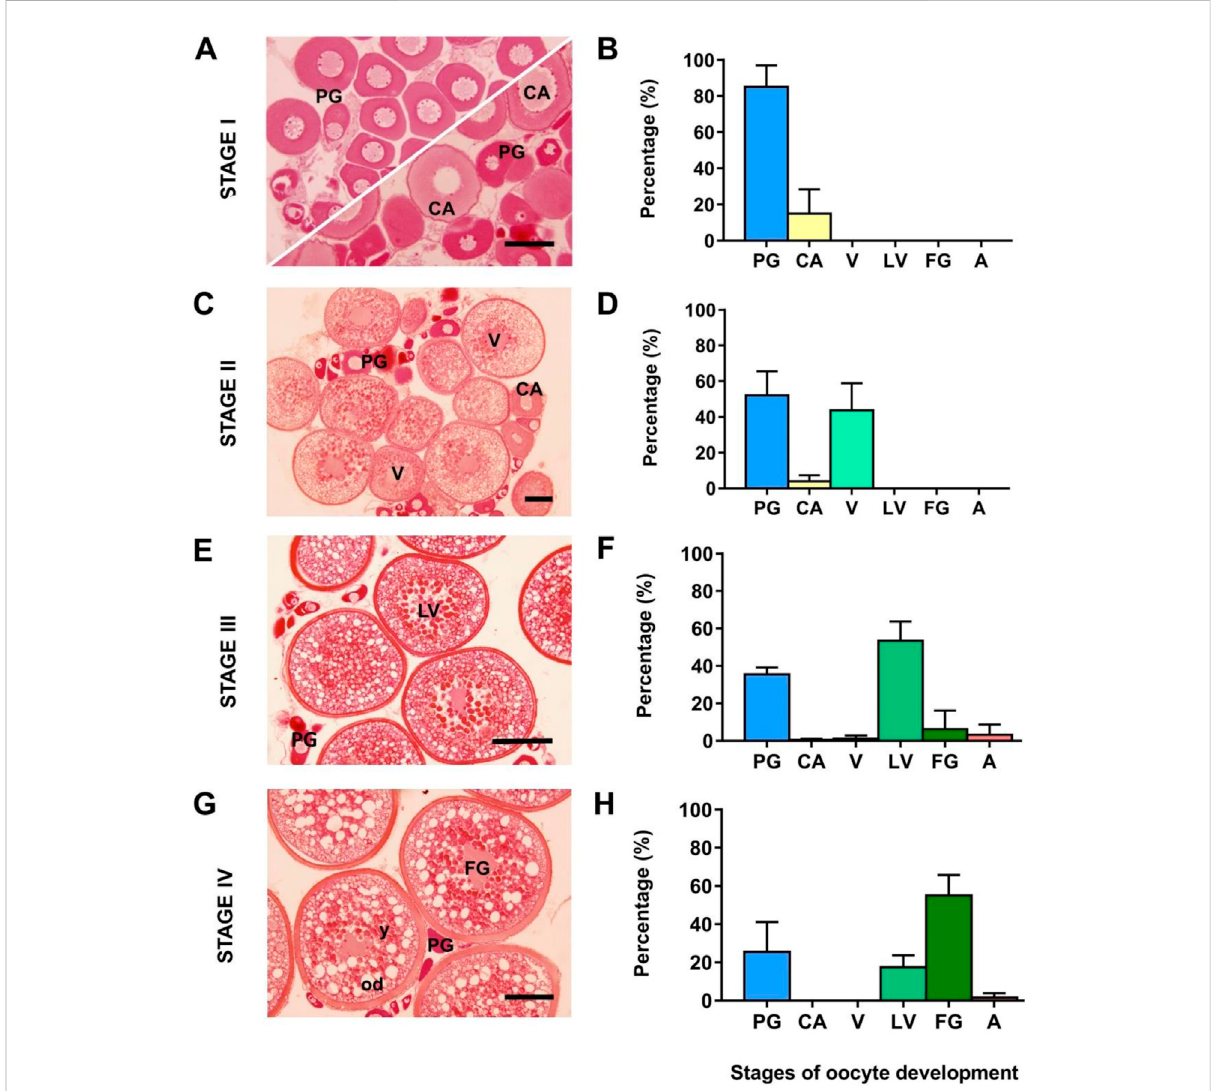
FIGURE 2 Development of the fl athead grey mullet ( Mugil cephalus ) ovaries representing the four points at which samples used for transcriptome sequencing were collected. Light micrographs (A,C,E and G) of oocytes stained with hematoxylin-eosin are representative of the fi sh used. Frequency of oocytes in the ovary at each sampling point (B,D,F and H) at different developmental stages are presented as the mean ± SD (n = 5 females per stage). (A) Previtellogenic ovary (C) early-to-mid vitellogenic ovary (E) late-vitellogenic ovary; and (G) ovary with full-grown oocytes. PG, primary growth oocytes; CA, cortical alveolus stage; V, early-to-mid-vitellogenesis; LV, late-vitellogenesis; FG, full-grown oocyte; od, oil droplets; y, yolk. Scale bars correspond to 100 μ m (A and C) and 200 μ m (E and G)